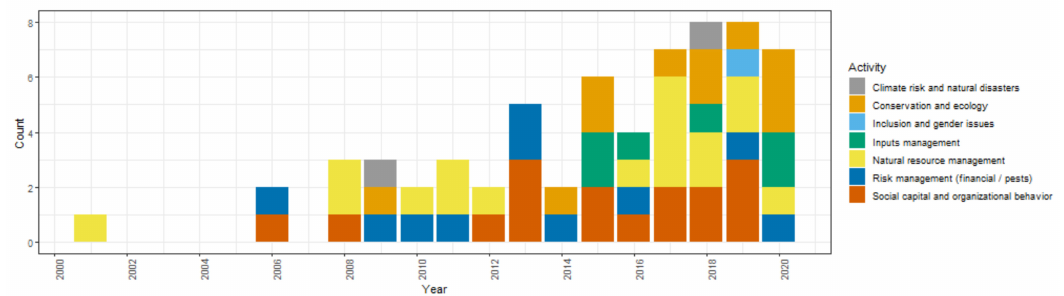
Figure A2. Frequency of behavioral and cognitive bias studies by type.